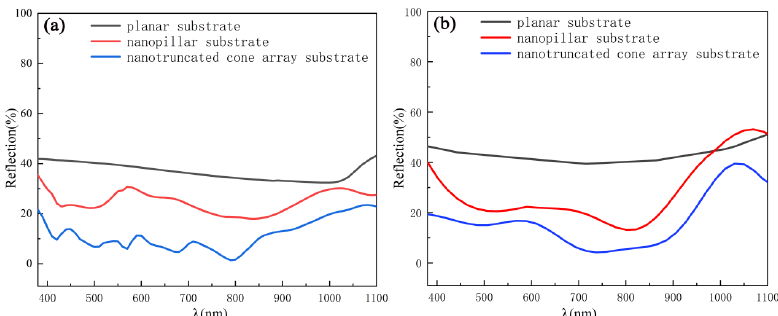
Figure 5. Reflections of planar, nanopillar, and nanometer truncated cone substrates obtained by ( a ) simulation and ( b ) experimental.